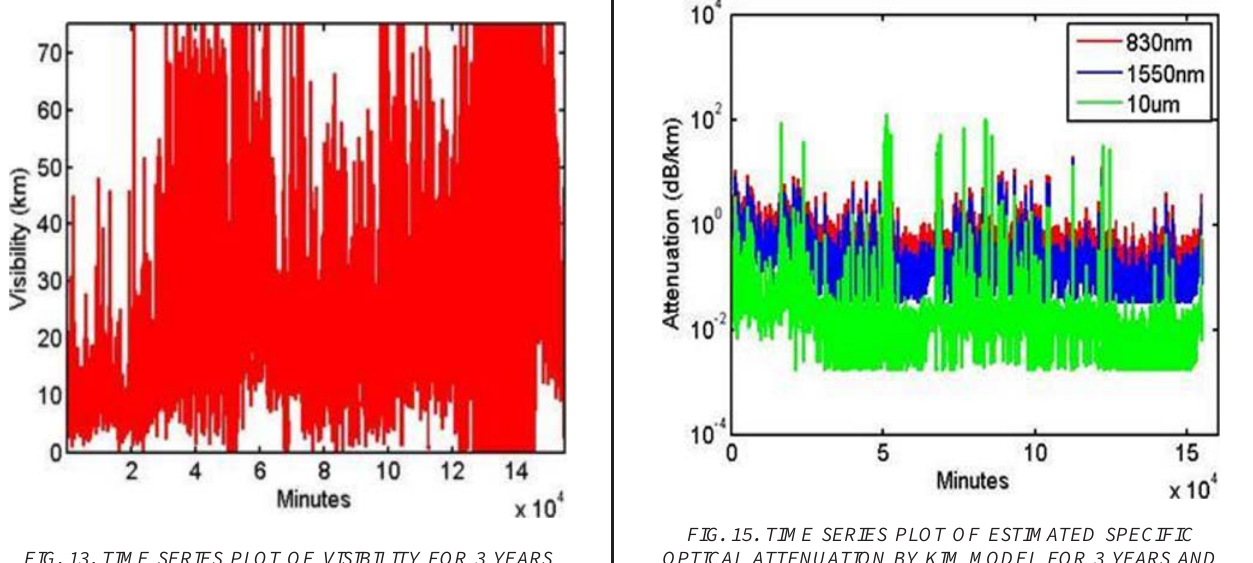
FIG. 13. TIME SERIES PLOT OF VISIBILITY FOR 3 YEARS AND 4 MONTHS